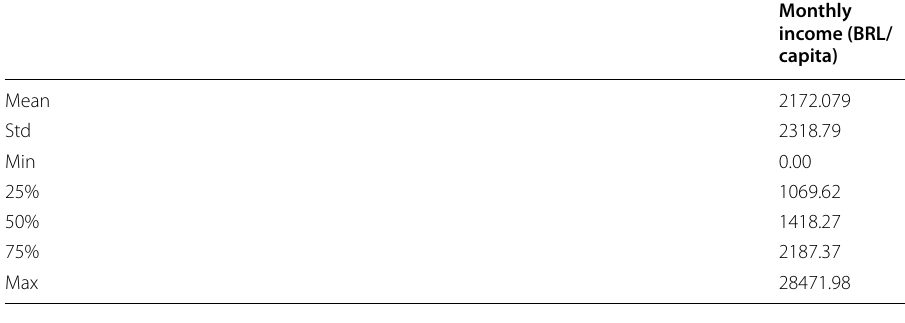
Table 1 Summary statistics of average income per capita (Brazilian Real per month) across hexagon